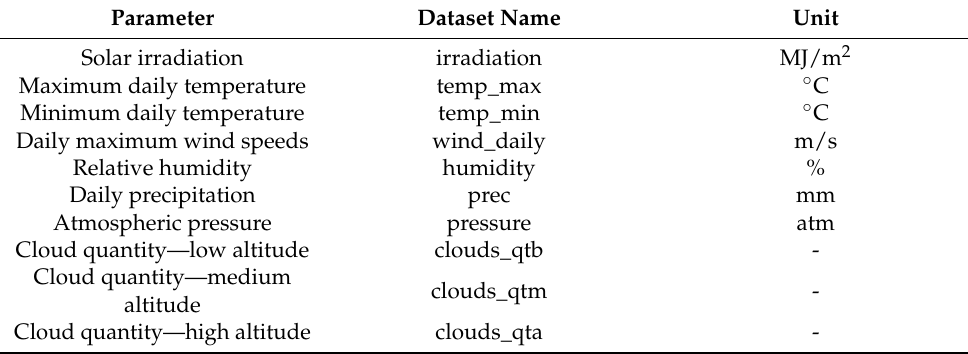
Table 1. Dataset description.